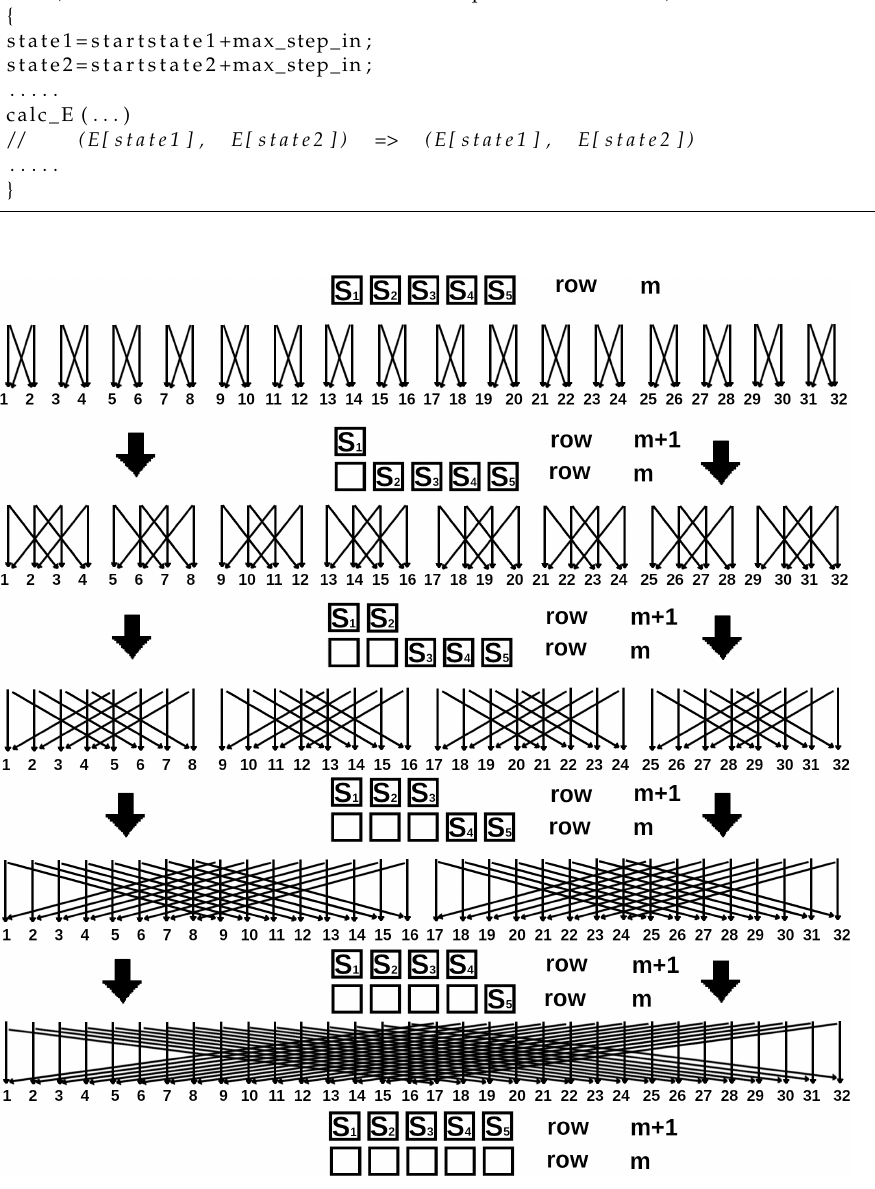
Figure 2. Partitioning of the states of the lattice spin boundary with L x = 5 into pairs when extending the row number m + 1. To complete the row, 5 spins must be added. Starting from the second row, pairing no longer takes place between adjacent memory cells. Thus, the arrows can intersect many times. The numbers under the arrows signify the locations of the memory. In turn, the each location corresponds to the given state of a spin boundary. The arrows show the transmission of the values of the energy to calculate the next energy minima according to (4) and